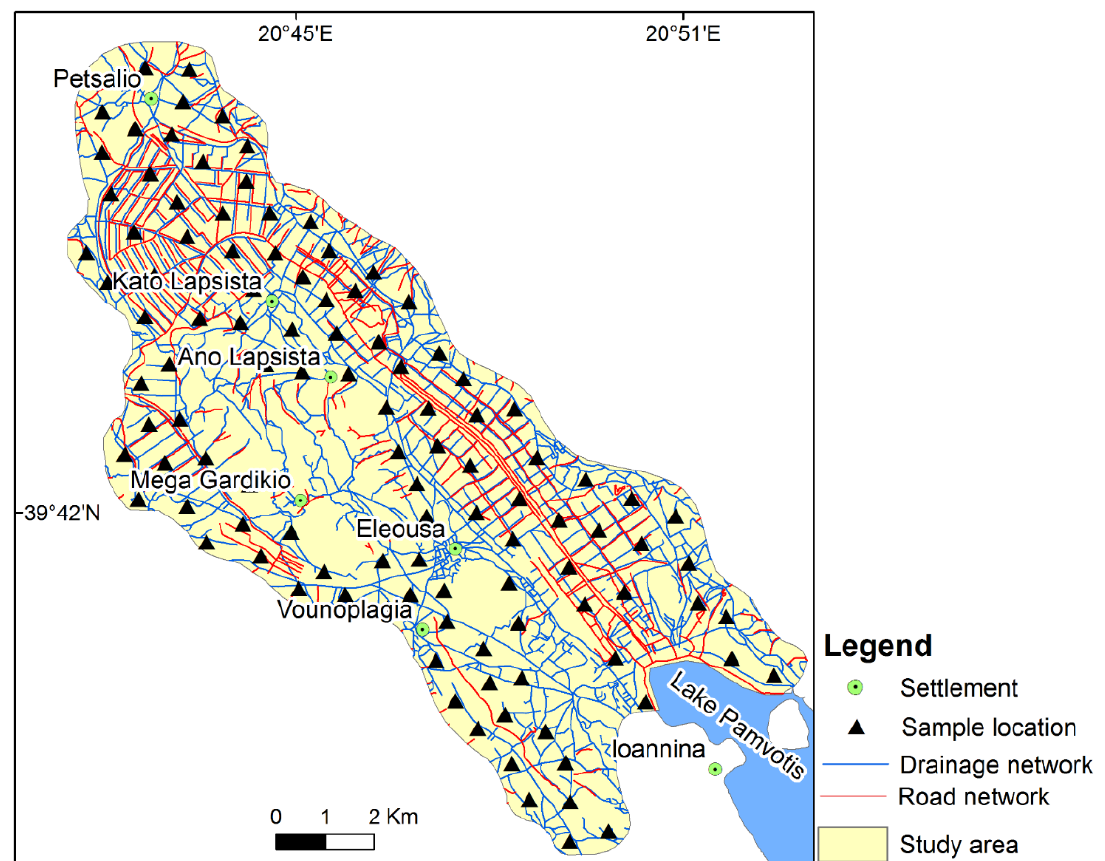
Figure 4. Map showing soil sampling sites in the Ioannina plain.